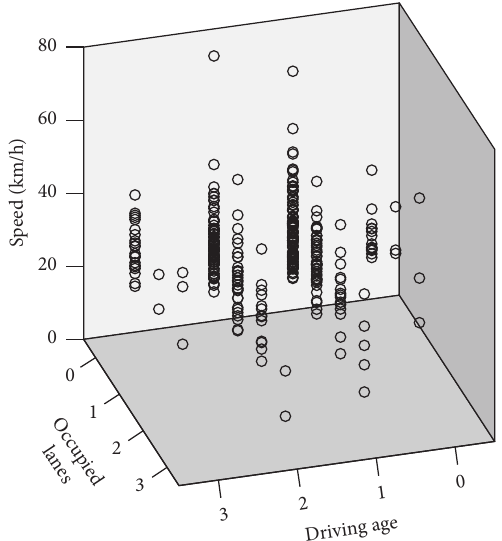
Figure 13: Relationship between driving age, traveling speed, and illegal lane occupation